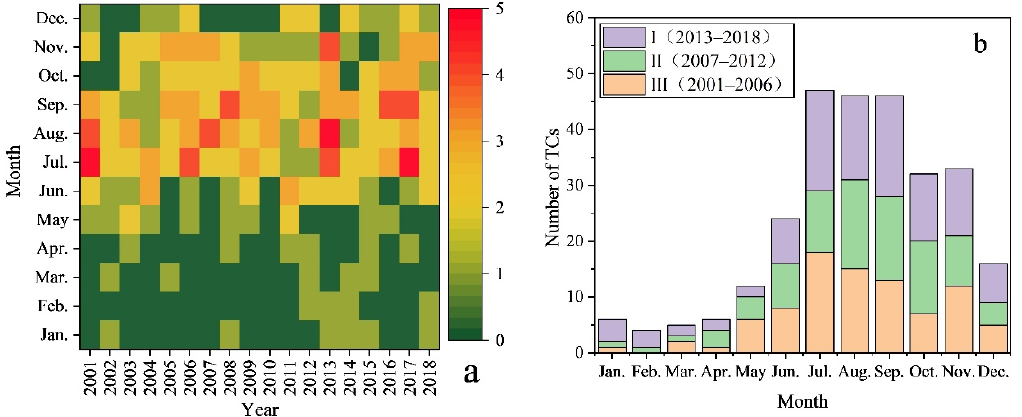
Figure 3. ( a ) Distributions of TCs in different years (2001–2018); ( b ) average monthly occurrence of TCs in different stages.